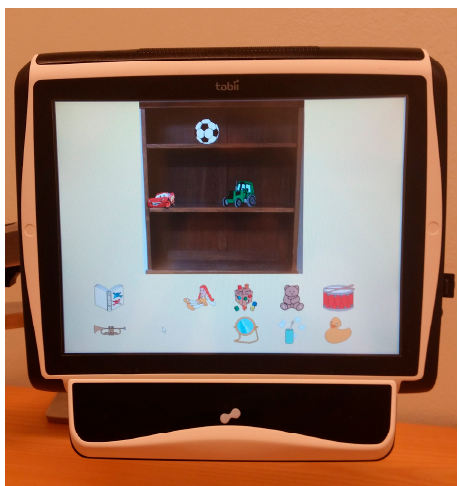
Figure 2. Example of a page with a play activity in the eye-gaze control technology. When fixating ones eye gaze on a toy, it moves to the shelf.